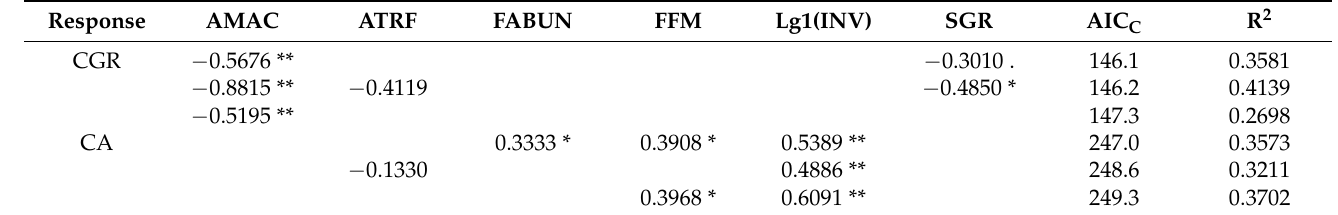
Table 4. Results of the AIC C based model selection for the environmental variables coral genus richness (CGR) and coral cover (CA), using the predictor variables AMAC (macroalgae), ATRF (turf algae), FABUND (fish abundance), FFM (fish family richness), Lg1(INV) (log-transformed herbivorous invertebrate abundance), and SGR (seagrass). ‘*’ p < 0.05; ‘**’ p < 0.01; ‘.’ 0.05 < p < 0.10. Successive lines show the results for the best supported, and second- and third-best supported